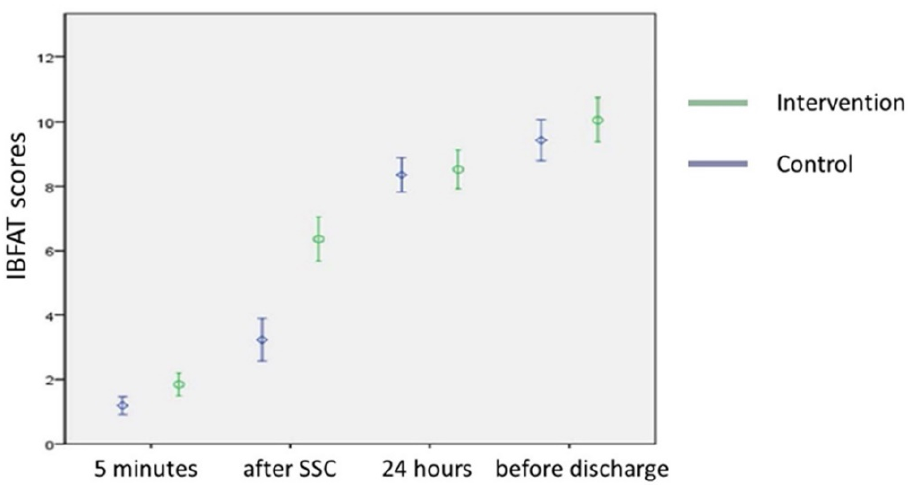
Figure 2. Evaluation of newborn breastfeeding ability at different time points between the interven- tion and control groups (data are presented as the median with 95% CI).